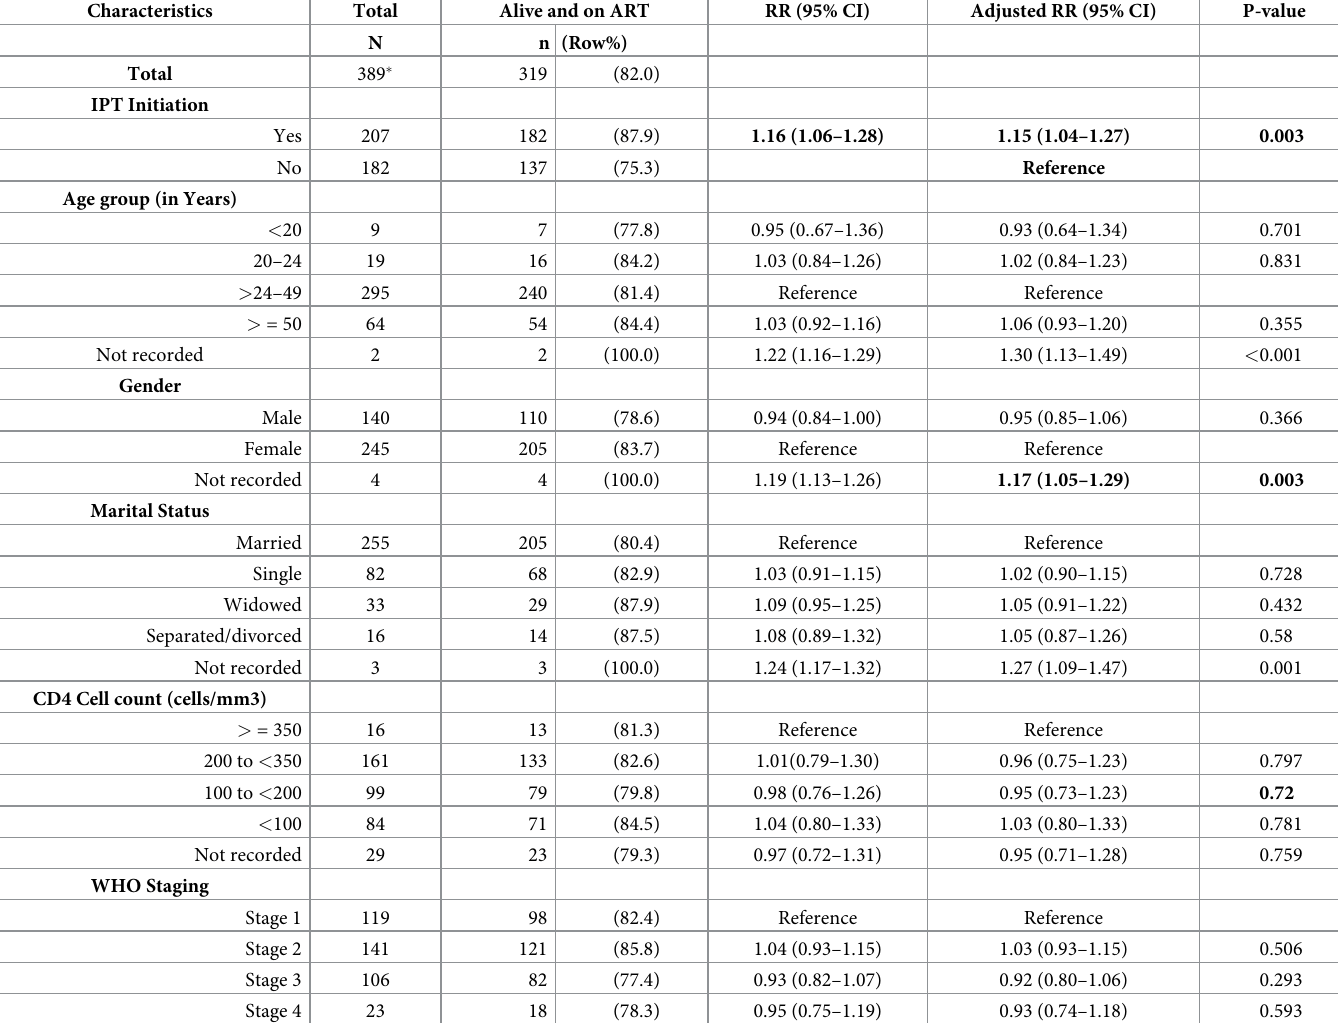
Table 3. Characteristics associated with retention in care by the end of 2017 among IPT eligible PLHIV who were initiated on ART in Bulawayo, Zimbabwe from October 2013 to March 2014.